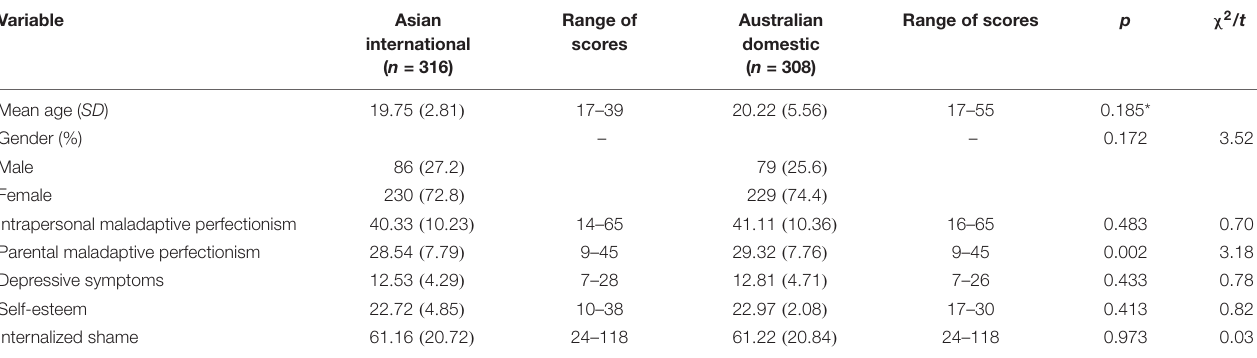
TABLE 1 | Descriptive statistics of the sample and main variables.